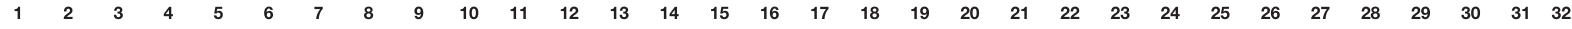
TABLE 3 | Linkage disequilibrium (LD) score of the single nucleotide polymorphisms in the quail prion protein gene ( PRNP